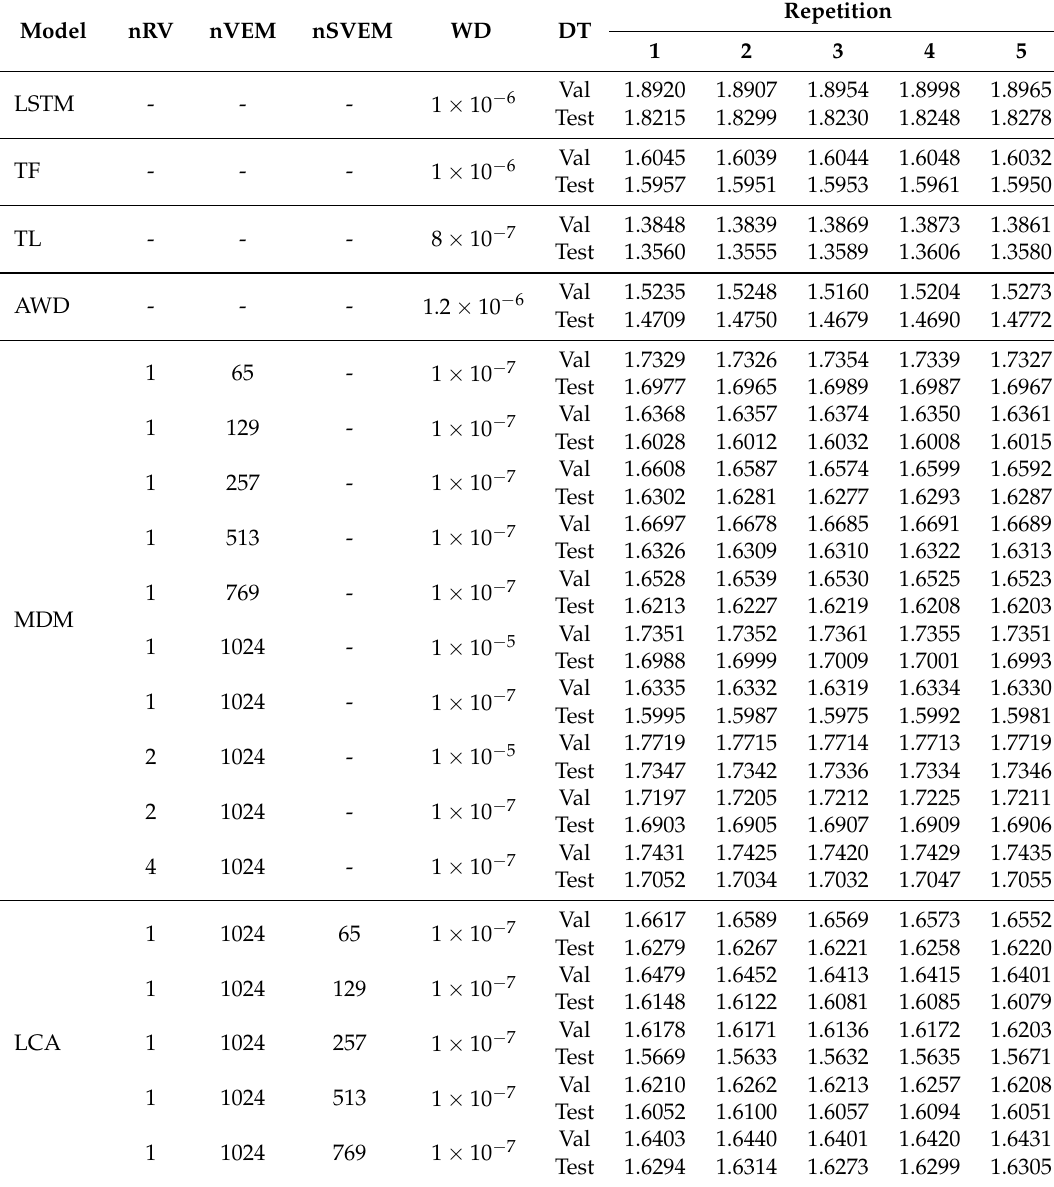
Table A1. Each BPC sample of evaluation results on the PTB LM task (nRV, number of read vectors; nVEM, number of vectors in the external memory; nSVEM, number of selected vectors in the external memory; WD, weight decay; DT, data type; TF, Transformer; TL, trellis network; AWD,